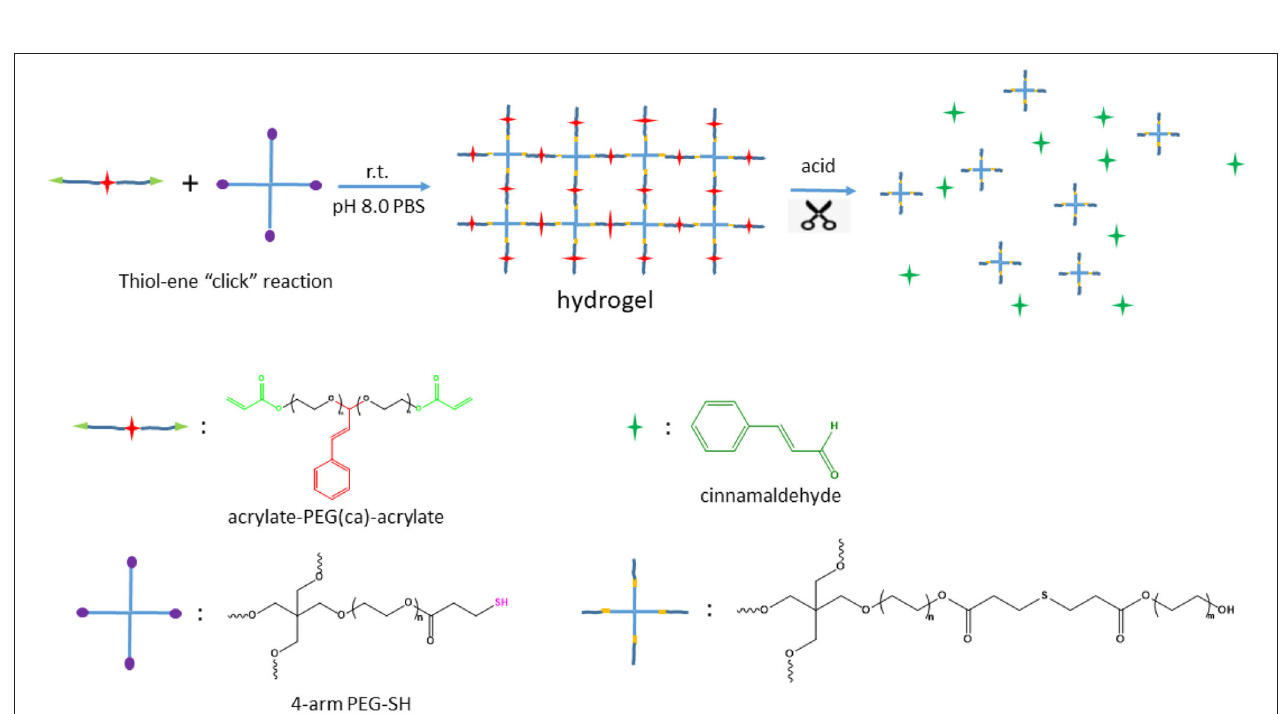
SCHEME 2 | Fabrication and degradation of